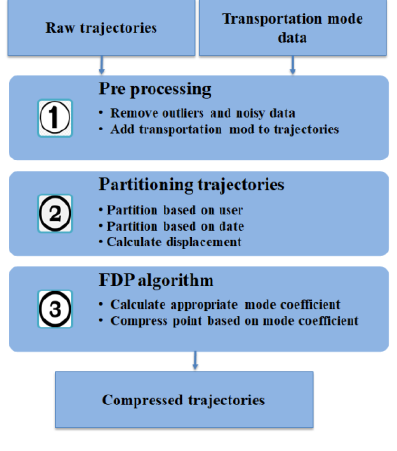
Figure 3 . Proposed